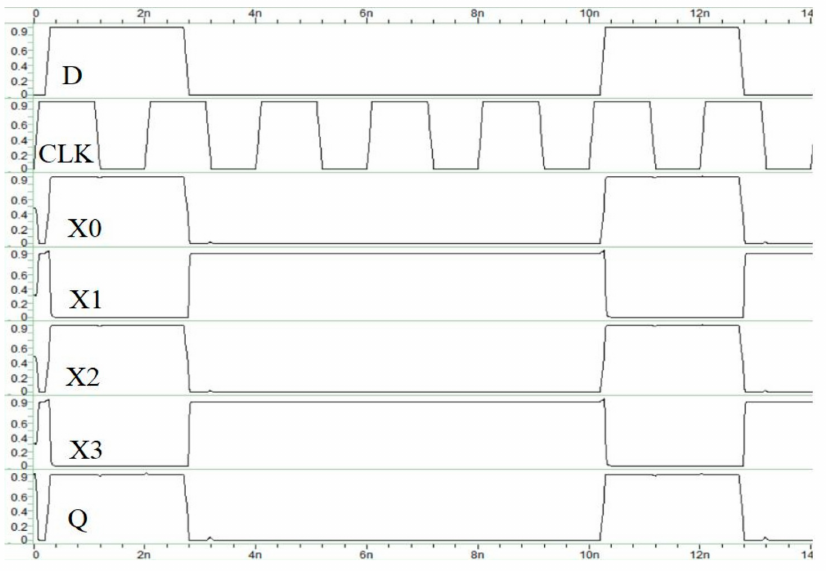
Figure 9. Simulation result under normal working